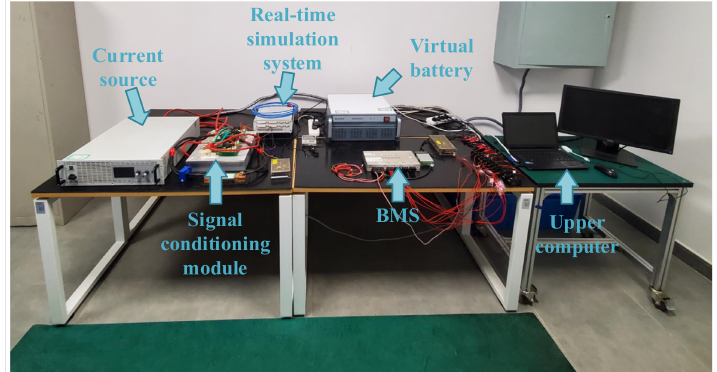
Figure 4. Physical view of battery management system testing